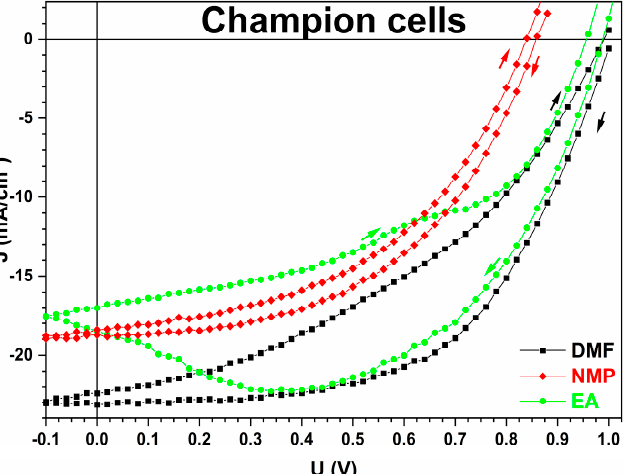
Figure 4. Photovoltaic characteristics for the champion PSCs obtained with different solvents. The arrows point towards the direction of the measurements (starting from the V oc to J sc and backwards).